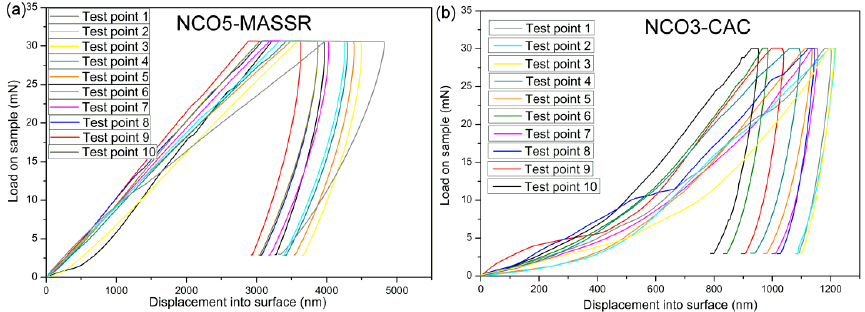
Figure 8. Load ‐ displacement curves for ( a ) NCO5 ‐ MASSR and ( b ) NCO3 ‐ CAC samples.